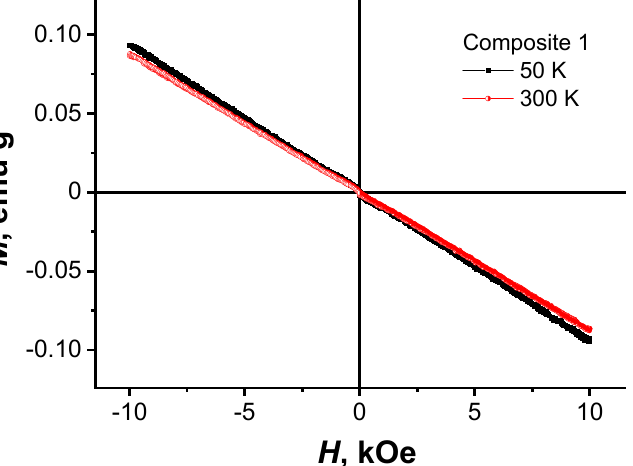
Figure 7. Dependence of the magnetic moment versus magnetic field for composite 1 at T = 50 and 300 K.